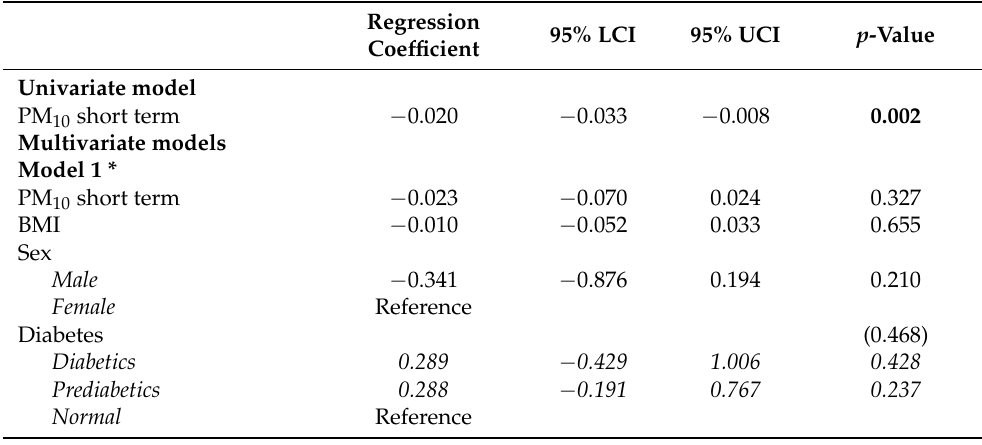
Table 4. Association between PM 10 short term and DNA adducts from univariate and multivariate regression analysis. Statistically significant results are highlighted in bold character in p -Value